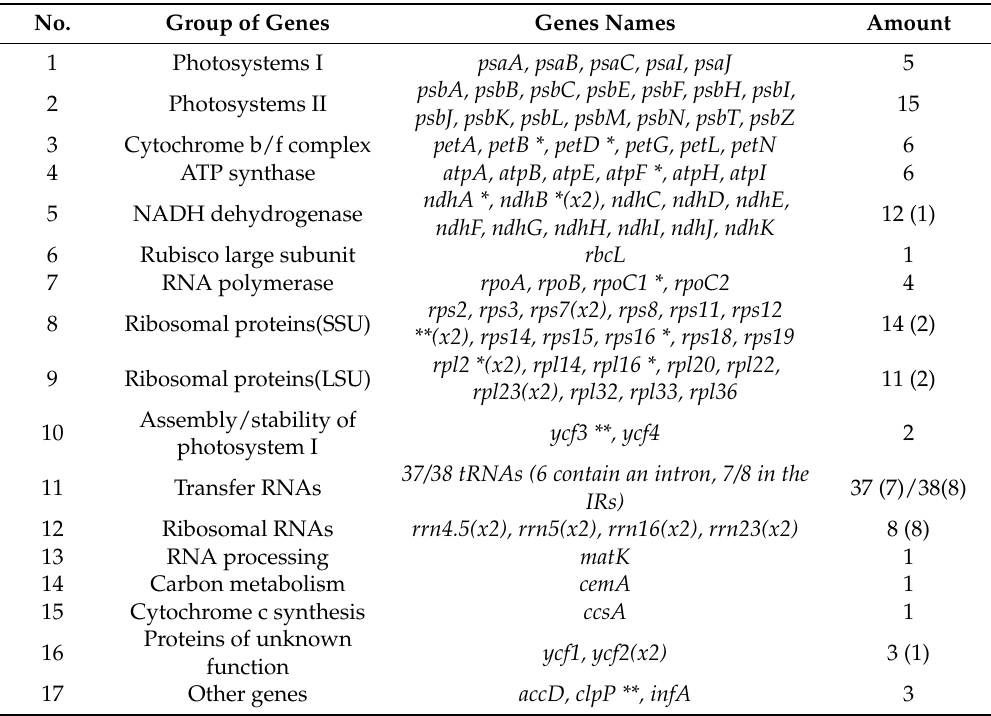
Table 2. Gene contents in the cp genomes of Aristolochia species.